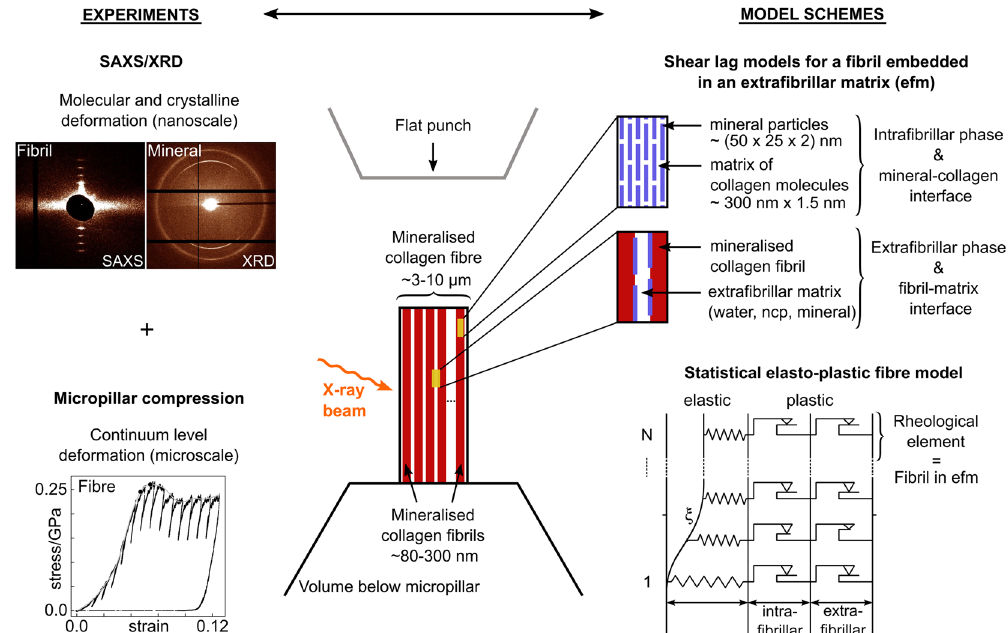
Figure 1. Development of the experimentally informed statistical elasto-plastic model for the mineralised collagen fibre at the micro- and nanoscale. The apparent fibre behaviour was quantified by compressing fibre micropillars (continuum level; microscale deformation) while determining molecular and crystalline deformations via fibril and mineral strains (nanoscale deformation) with small angle X-ray scattering (SAXS) and X-ray diffraction (XRD, WAXS) 39 . The elasto-plastic behaviour of intra- and extrafibrillar phases is modelled via two nested shear lag models and two inelastic strain mechanisms at mineral-collagen and fibril- matrix interfaces. The fibre itself is then represented by a parallel arrangement of fibrils with variable material properties where a rheological element represents a fibril embedded in an extrafibrillar